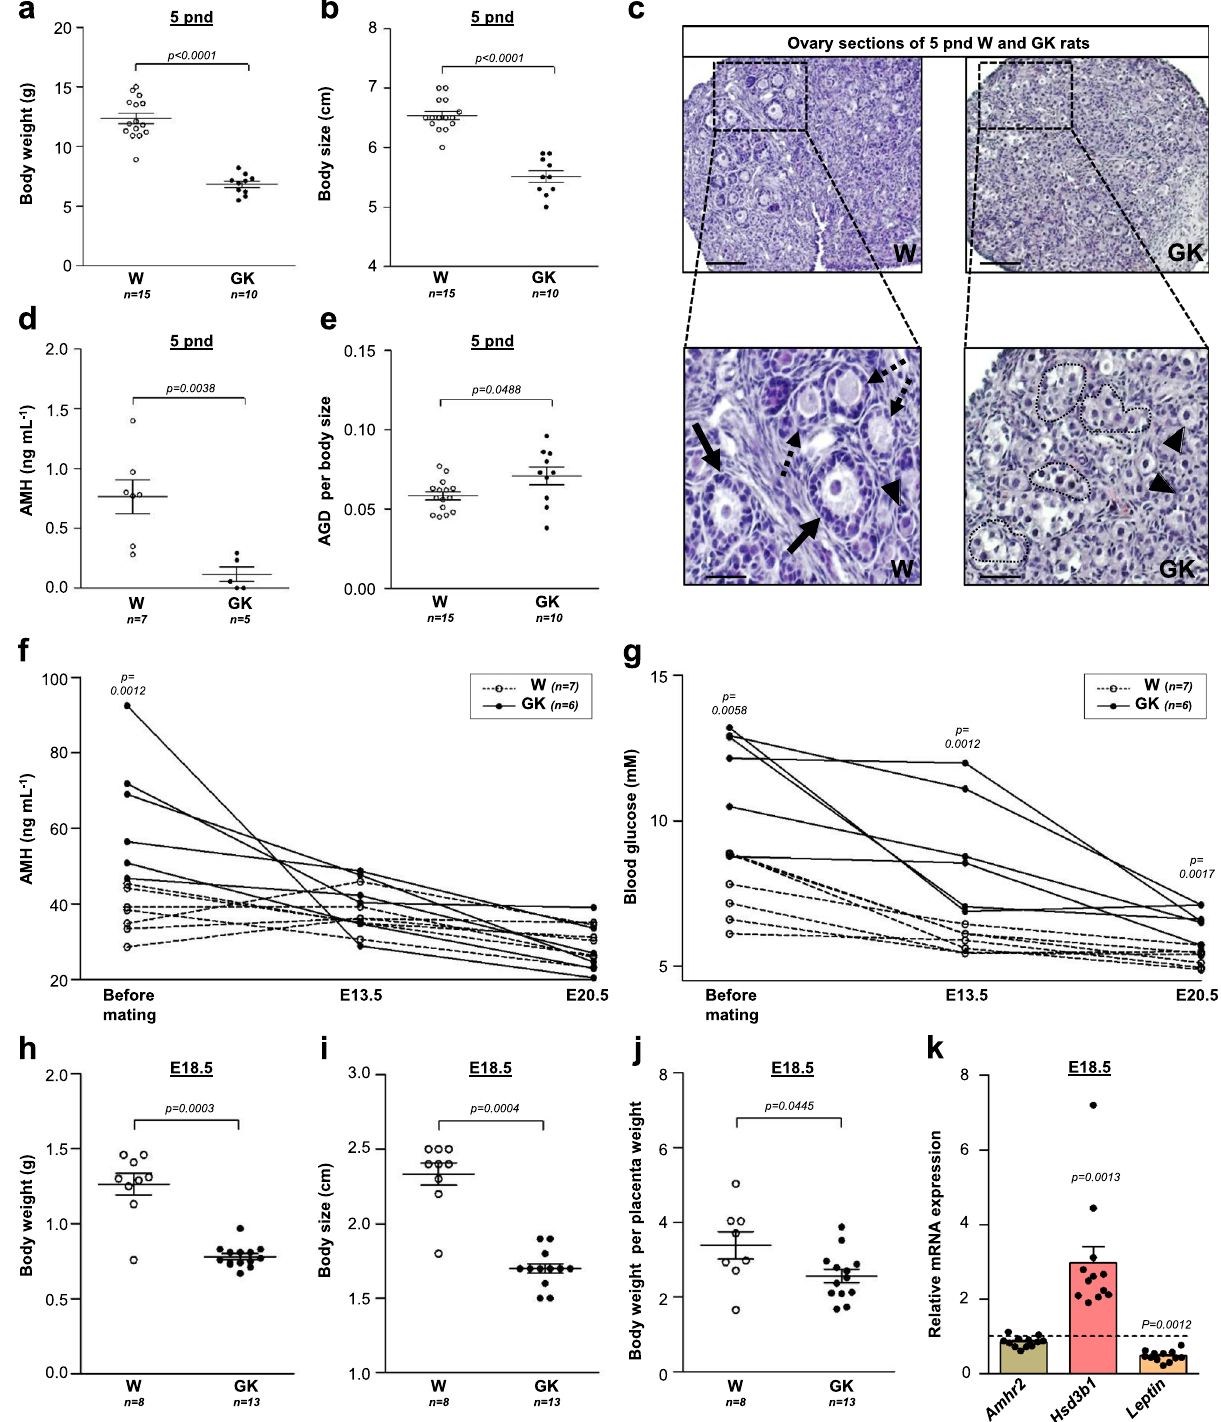
Fig. 6 Study of fetal and postnatal development of Wistar and GK rats. a , b Body weight ( a ) and size ( b ) of 5 postnatal days (pnd) Wistar (W, open symbols) and GK (closed symbols) rats. c Representative histological sections of hematoxylin – eosin-stained ovaries of 5 pnd Wistar (left, n = 7) and GK (right, n = 5) rats. Black arrows: secondary follicles; dotted arrows: primary follicles; arrowheads: primordial follicles. Black dotted lines encircle the oocyte nest. Scale bars = 100 or 25 µ m. d Serum AMH levels assessed on 5 pnd rats. e Anogenital distance (AGD) of 5 pnd rats. f , g Serum AMH ( f ) and blood glucose ( g ) levels measured before mating and at embryonic days (E) 13.5 and E20.5 of gestation on 2 month-old Wistar and GK rats. h , i Body weight ( h ) and size ( i ) of Wistar and GK rats fetuses at E18.5. j Ratio between body weight and placenta weight of E18.5 Wistar and GK rat fetuses. k Amhr2 (beige) , Hsd3b1 (salmon), and Leptin (orange) mRNA levels in placenta of E18.5 GK rat fetuses, expressed as box with scatter blot with mean ± SEM ( GK: n = 12; fold change relative to Wistar rats; W: n = 9). Unless indicated, data are represented as scatter blot with mean ± SEM. p -values are from two- sided Mann – Whitney U test for unpaired comparisons (GK vs. Wistar rats). n represents the number of biologically independent animals in each group. Source data are provided as a Source Data fi